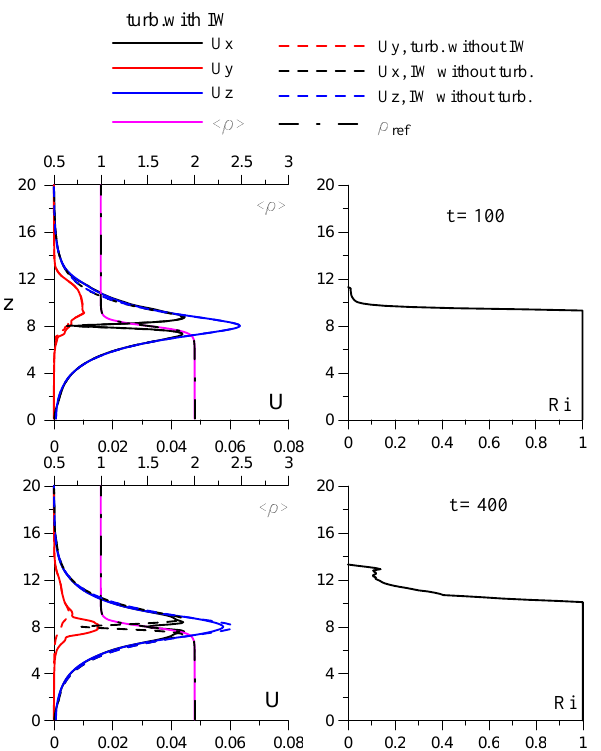
Figure 4. Vertical profiles of the rms velocity components, U (cid:48) x , U (cid:48) y , U (cid:48) z , mean density < ρ > (left) and the gradient Richardson num- ber, Ri g (right), obtained at time moments t = 100 and t = 100 in DNS with initially induced IW. The reference (initial) density pro- file, ρ ref (z) , is shown in dash-dotted (black) line. Profiles of the rms velocity x and z components of IW without turbulence are also shown in dashed line for